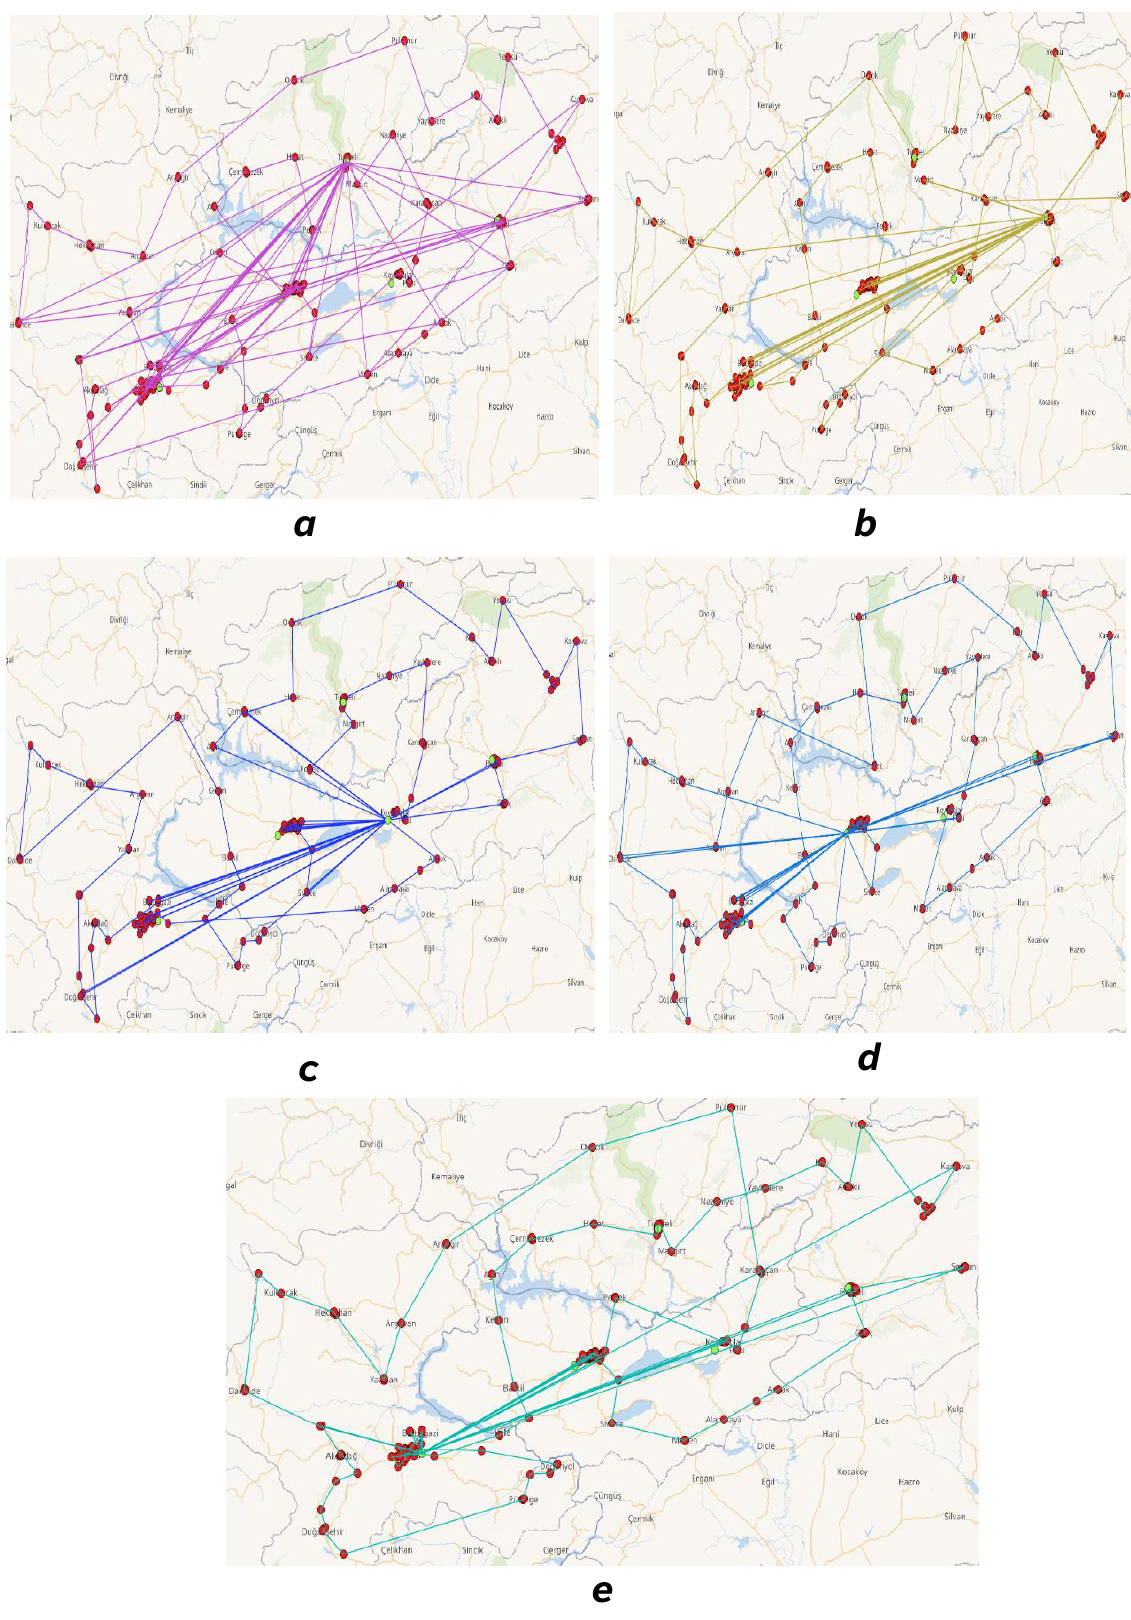
Figure 3. Feasible routes between collection and disposal center a) the disposal center located in Tunceli, b) the disposal center located in Bingöl, c) the disposal center located between Tunceli, Bingöl and Elazığ provinces, d) the disposal center located in Elazığ, e) the disposal center located in